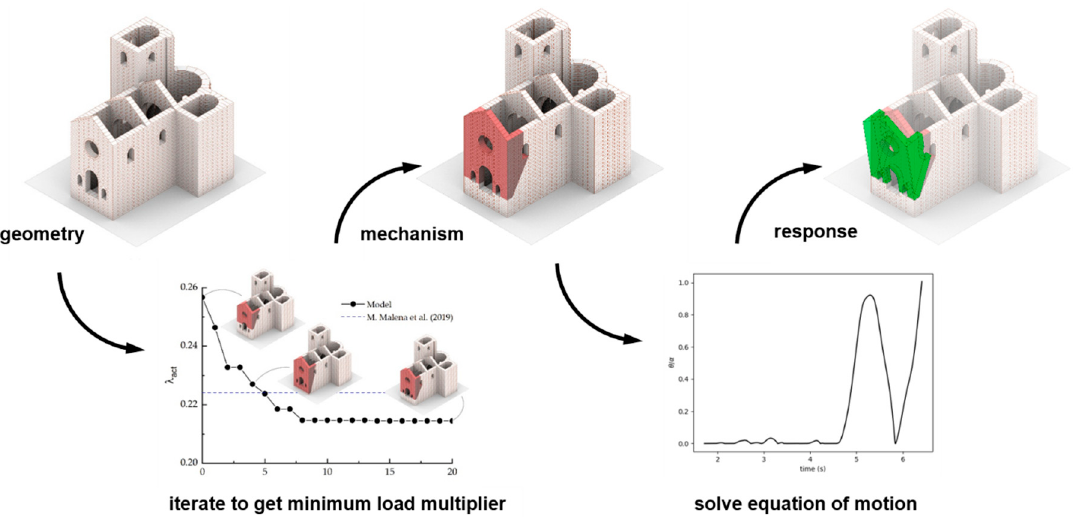
Figure 1. Overview of the proposed multi-level analysis procedure.